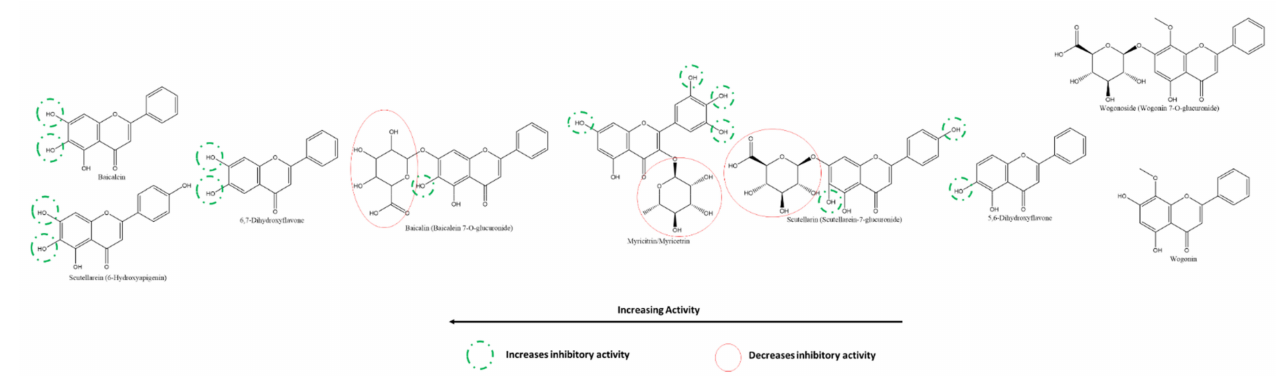
Figure 13. Structure–activity relationships of various flavones against SARS-CoV-2 3CLpro, adapted from the experiments of [119] using cell-based in vitro FRET assays. Substitutions and groups that result in an increase/decrease in inhibitory activities are shown in red and green, respectively.